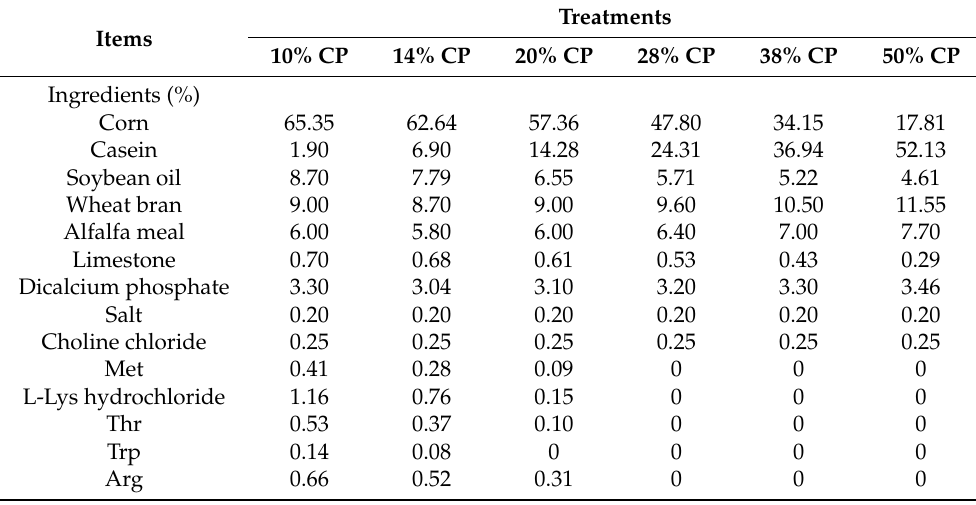
Table 1. Ingredients and composition of diets differing in CP